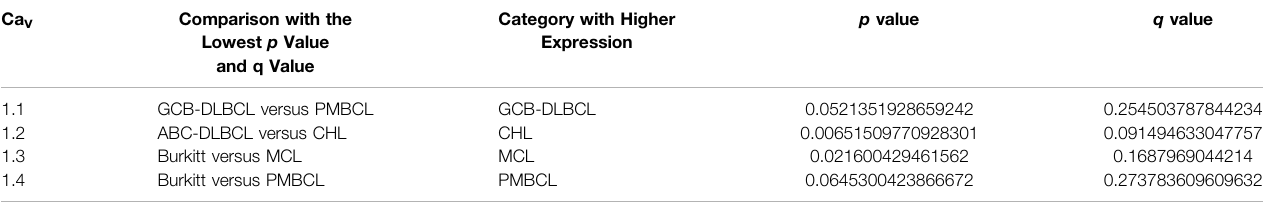
TABLE 3 | Comparisons of L-type Ca 2+ channel expression in cell lines. Statistical analysis is presented in the form of p values and q values. Ca V